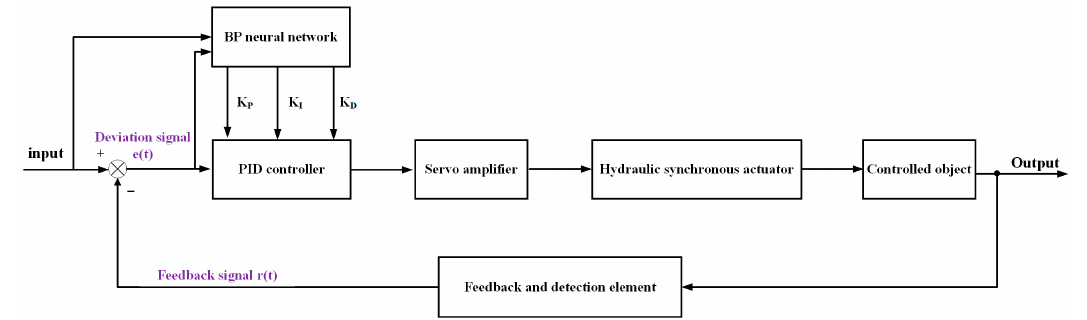
Figure 12. PID control principle under BP neural network.